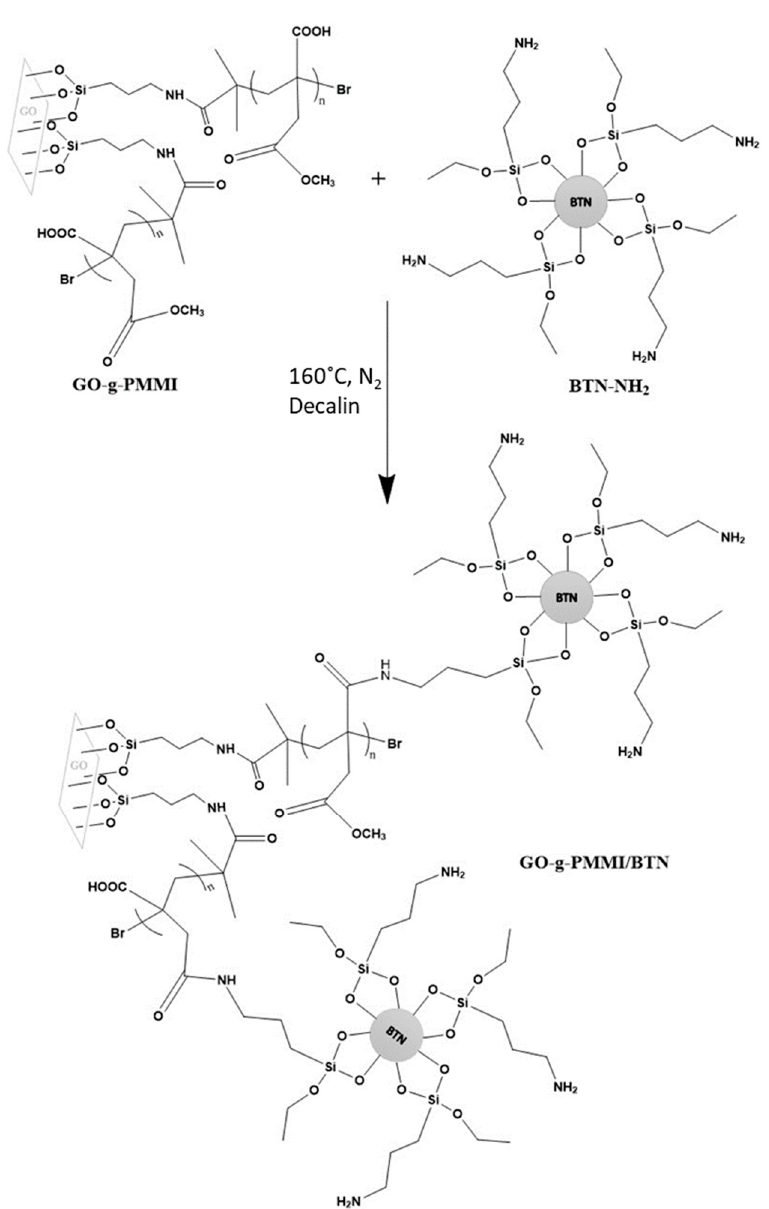
Figure 1. Proposed reaction scheme between silanized barium titanate nanoparticles (BTN-NH2) and GO-g-PMMI to yield hybrid GO-g-PMMI/BTN.